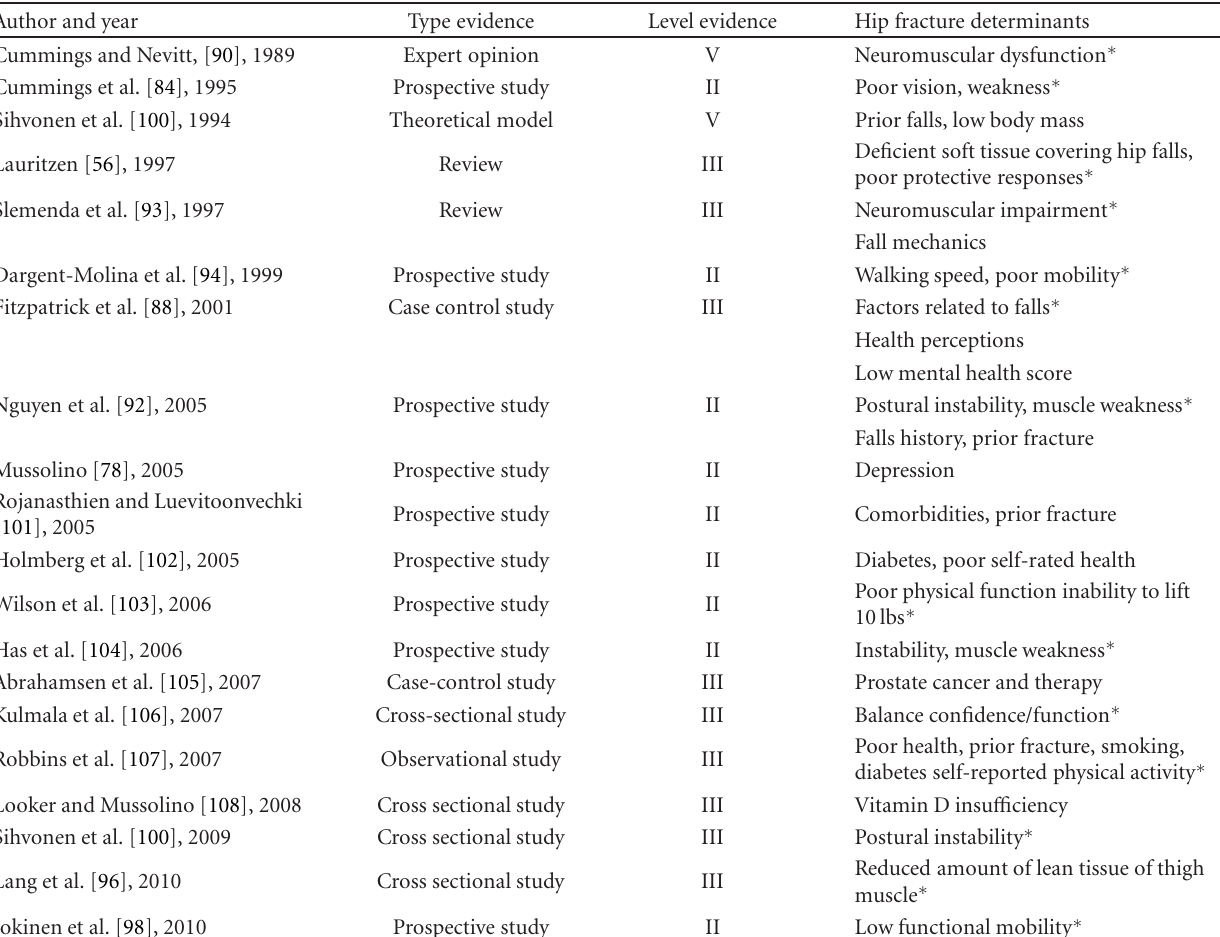
Table 2: Selected findings spanning a 20-year period describing various intrinsic factors other than age and bone mass as potential hip fracture determinants and showing a high percentage implicate neuromuscular factors ∗ . (Level evidence: I–V refers to study quality as outlined by the Oxford Centre for Evidence-Based